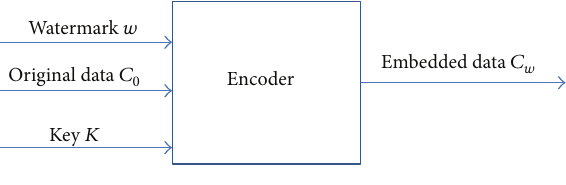
Figure 1: Insertion unit of watermark.